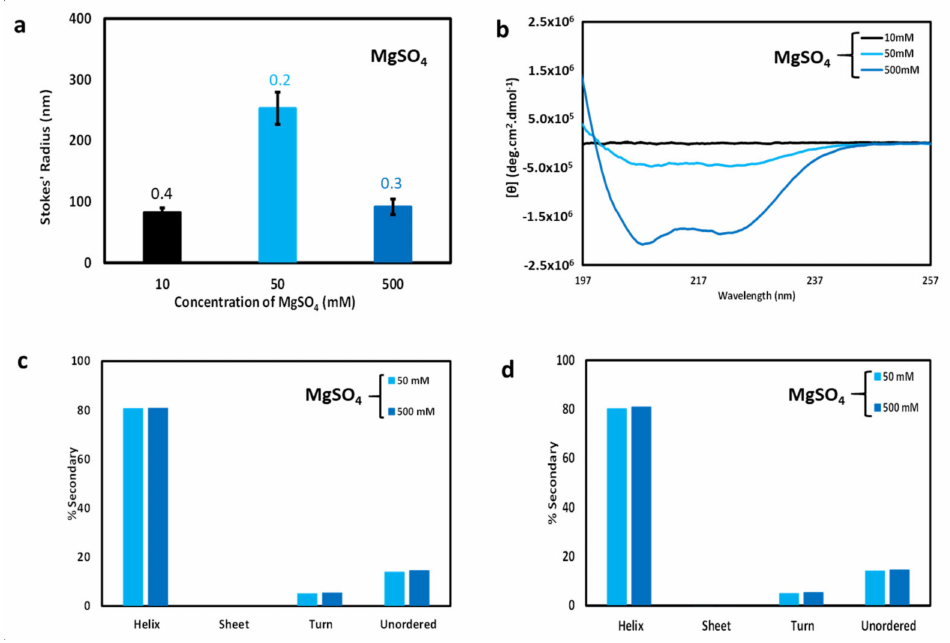
Figure 4. Effect of filtration on cl-Par-4 samples as a function of MgSO 4 concentration. ( a ) DLS- derived Stokes’ radii after filtering. Error bars represent the standard deviation in Stokes’ radii from multiple runs, and the number above each bar represents the average polydispersity value for these runs. ( b ) CD spectra after filtration. ( c ) Secondary structure analysis via deconvolution of CD spectra from Figure 2b [unfiltered samples]. ( d ) Secondary structure analysis via deconvolution of CD spectra from Figure 4b [filtered samples]. Secondary structure analysis of unfiltered and filtered 10 mM MgSO 4 samples was not possible due to the presence of large particles and low protein concentration,